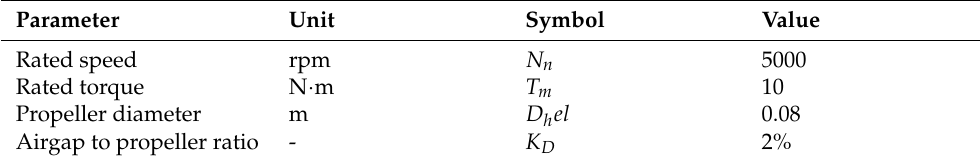
Table 3. Fixed input parameters.